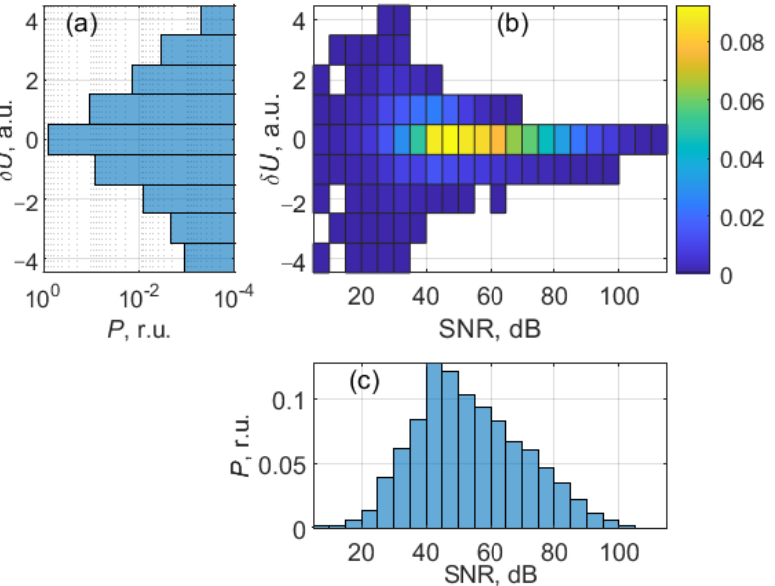
Figure 2. Relation of error of number of estimated components with signal-to-noise ratio. Error histogram of estimated number of components ( a ); two dimensional coincidence histogram of error and signal-to-noise ratio ( b ); signal-to-noise ratio histogram ( c